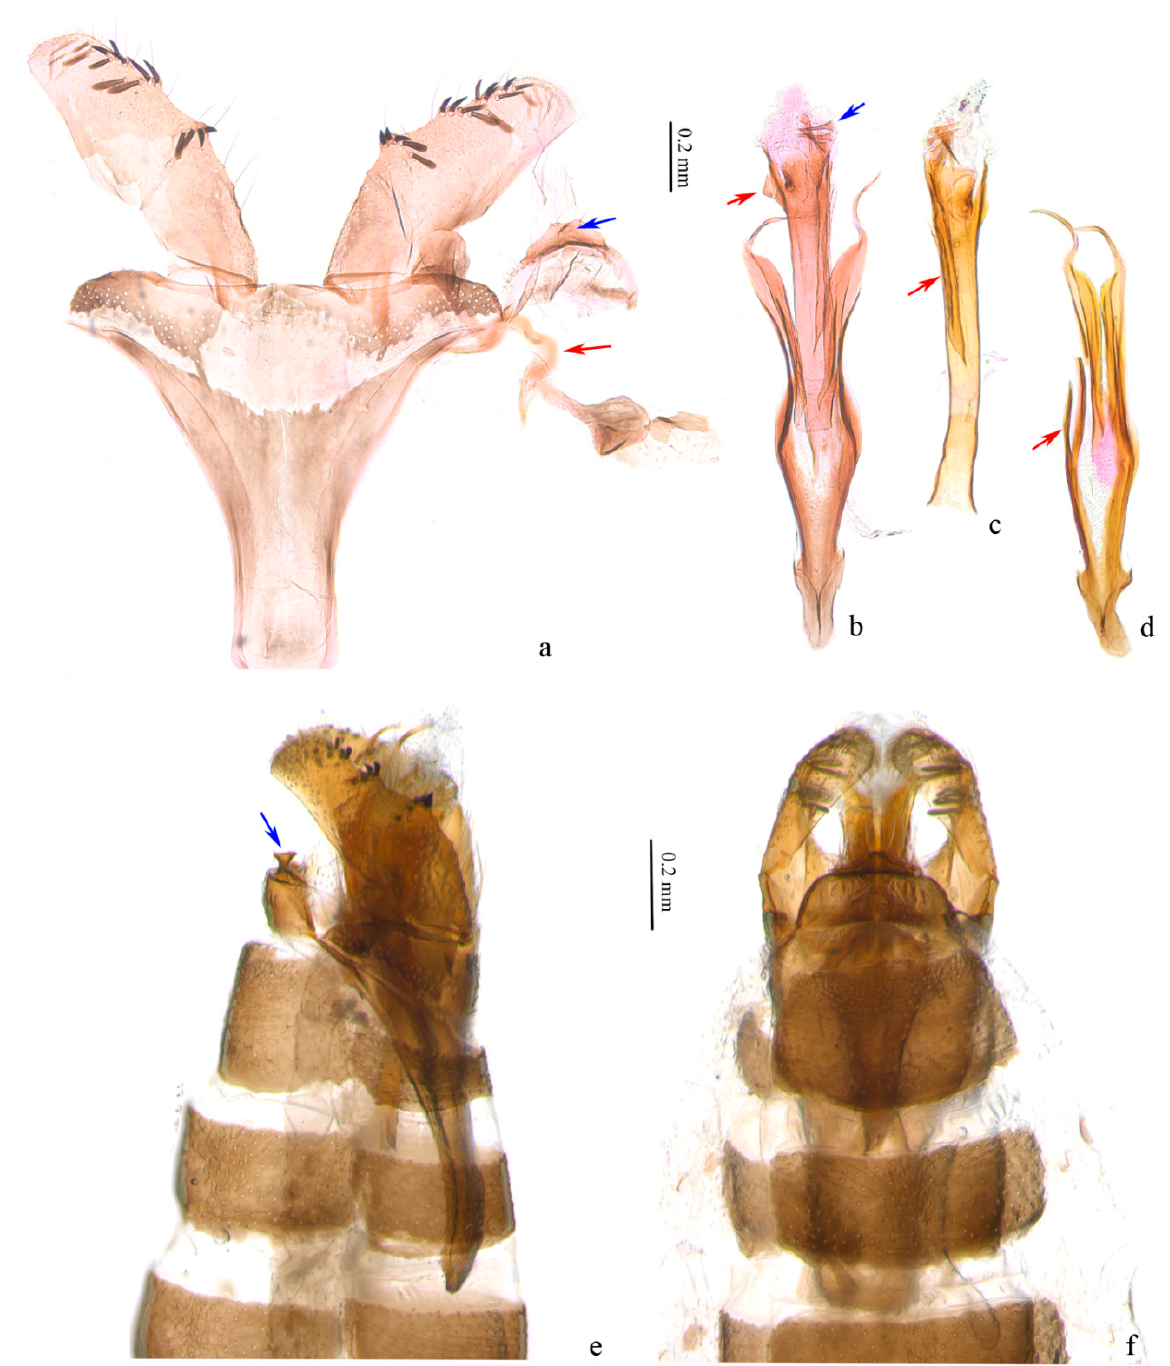
Figure 3. Male genitalia of Subclemensia taigae . ( a ) Genitalia with phallus detached, LIU0282, SDNU.Ent023846, blue arrow indicating the small sharp protrusion on tegumen, red arrow indicating the transtilla; ( b ) phallus, LIU0282, SDNU.Ent023846, red arrow indicating the small triangular protrusion, blue arrow indicating the cornuti; ( c ) phallus, LIU0288, SDNU.Ent023842, red arrow indicating the transtilla long ridge on outer wall; ( d ) juxta, LIU0288, SDNU.Ent023842, red arrow indicating the secondary branch; ( e ) genitalia in situ, lateral view, LIU0288, SDNU.Ent023842, blue arrow indicating the small sharp protrusion on tegumen; ( f ) foreleg, genitalia in situ, dorsal view, LIU0288, SDNU.Ent023842. Female genitalia (Figure 4). Ovipositor arrow-shaped, apex blunt, with 3 serrations on each side (Figure 4b). Apophyses equal in length, with short bifurcation at middle of